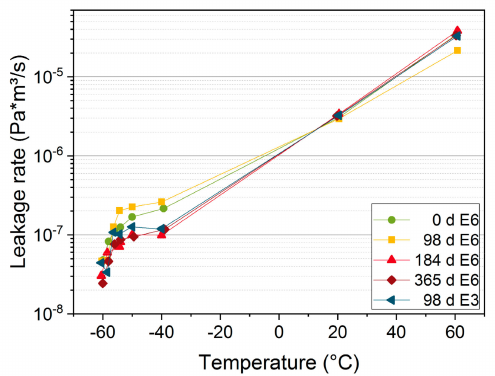
Figure 9. Leakage rate of the seal E6 aged at 125 ◦ C and E3 aged at 150 ◦ C for the respective aging periods vs.